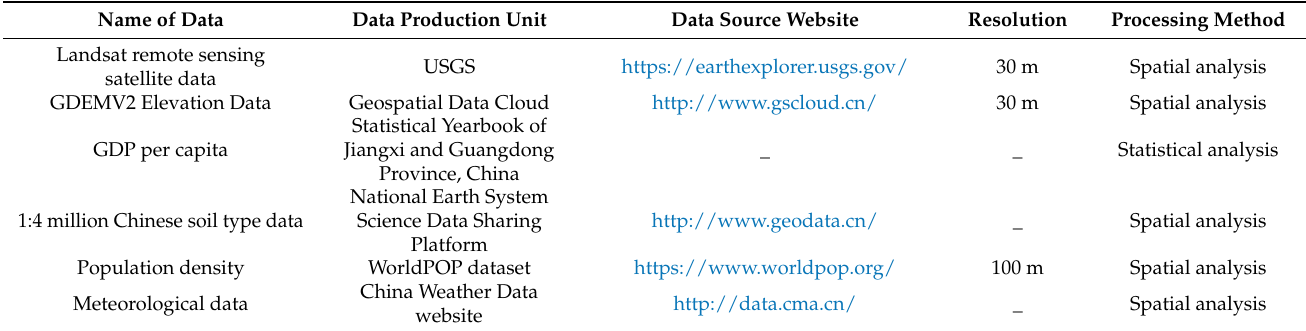
Table 1. Data sources and